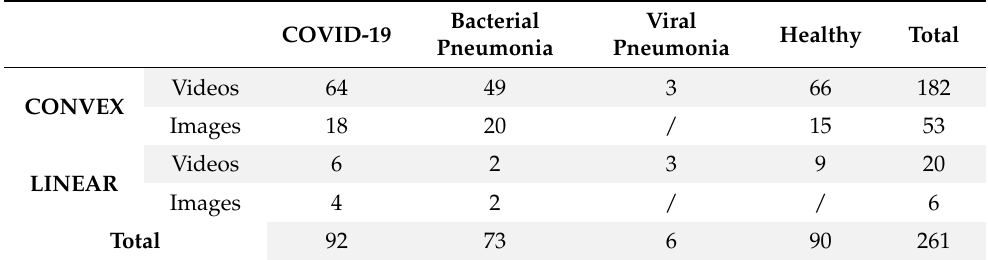
Table 1. The class distribution of the POCUS